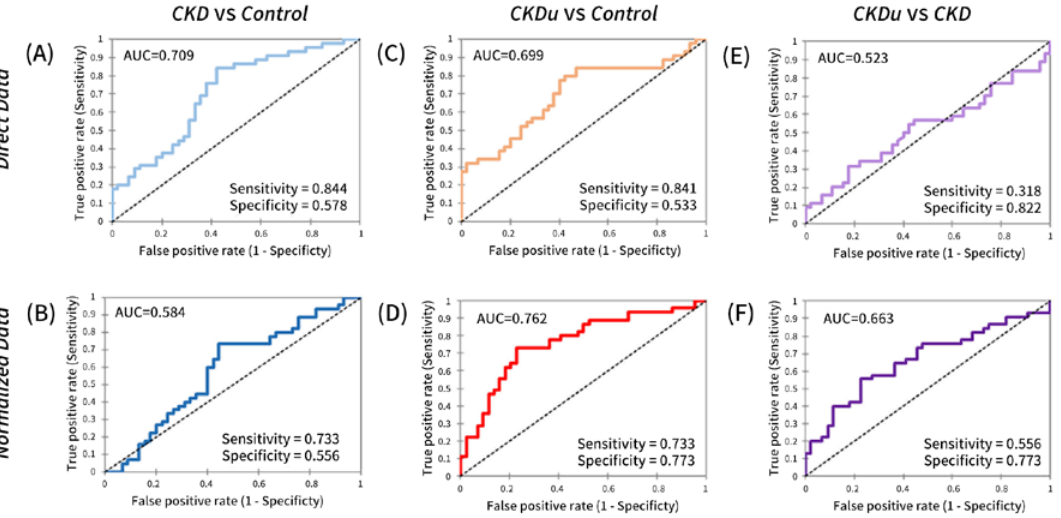
Figure 3. Serum RBP4 performance as marker. ( A , B ) ROCs showing performance of RBP4 as a marker for CKD. ( C , D ) ROCs showing performance of RBP4 as a marker for CKDu. ( E , F ) ROCs showing performance of RBP4 as a discriminatory marker between the two chronic kidney diseases. Raw RBP4 values are used for ( A , C , E ), and normalized RBP4 indices are used for ( B , D , F ).